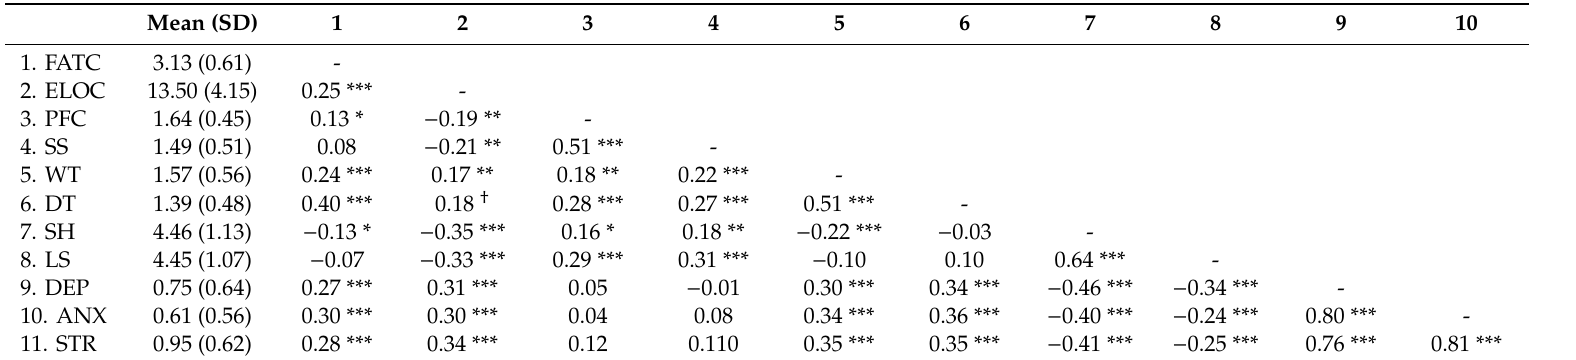
Table 1. Descriptive Statistics and Bivariate Correlations among the Measures in Study